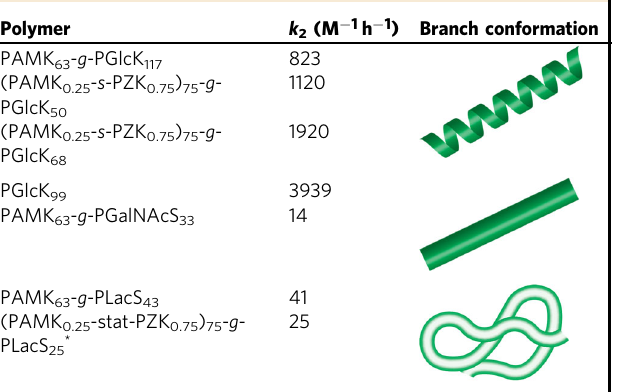
Table 2 Second-order kinetic parameters for NCA polymerization and growth of glycopolypeptide branches with various secondary structures and at varied graft